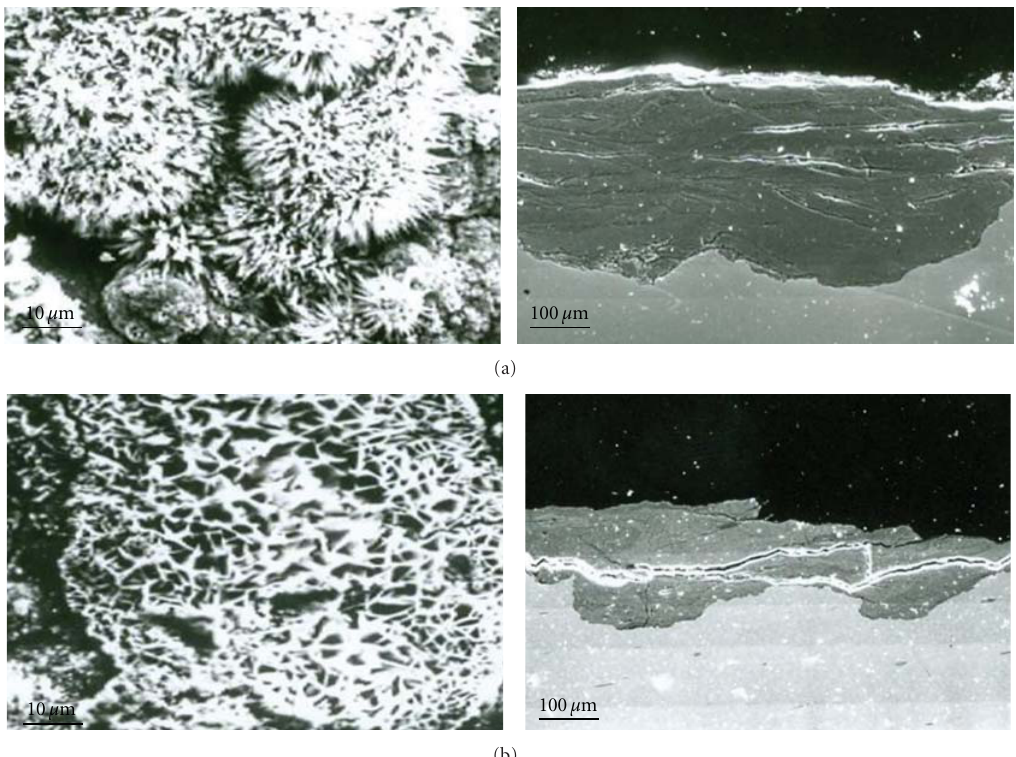
Figure 4: SEM micrographs of corrosion product layers formed on mild steel in pure marine atmospheres: (a) Puntarenas (S 1 P 0 ) and (b) Arraial do Cabo (S 2 P 0